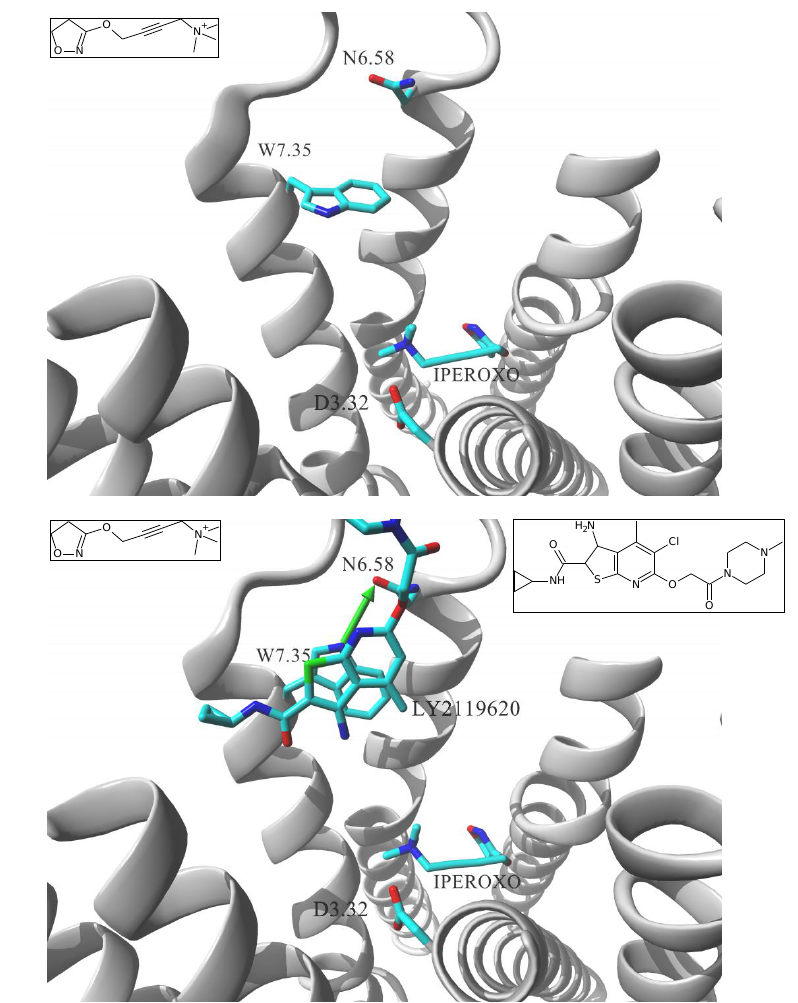
Figure 2. Structural model of M2 receptor cocrystalized with ( A ) iperoxo alone (4mqs.pdb) and ( B ) iperoxo + LY2119620 ligands (4mqt.pdb) [44]. Iperoxo resides at the ortosteric site, LY2119620 occupies the allosteric ELBD. The receptor molecule is shown in secondary structure mode (gray ribbon), parts are hidden for clarity. Ligand molecules and W422 7.35 , N410 6.58 and D103 3.32 residues are rendered in stick mode, interhelical HB in ( B ) is shown as a green arrow. Inset: chemical formula of ligands.